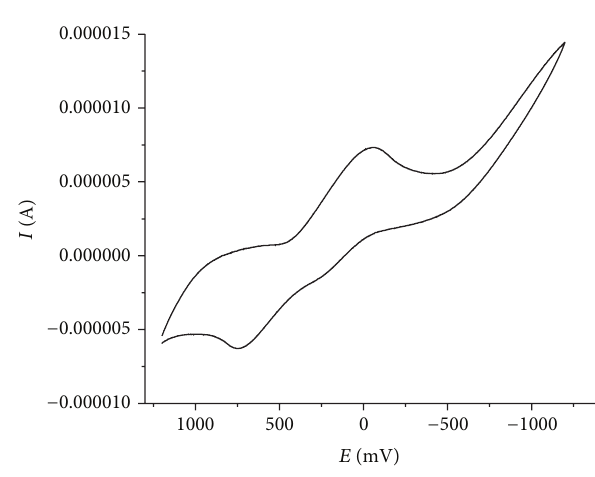
Figure 4: CV spectrum of Cu(II)